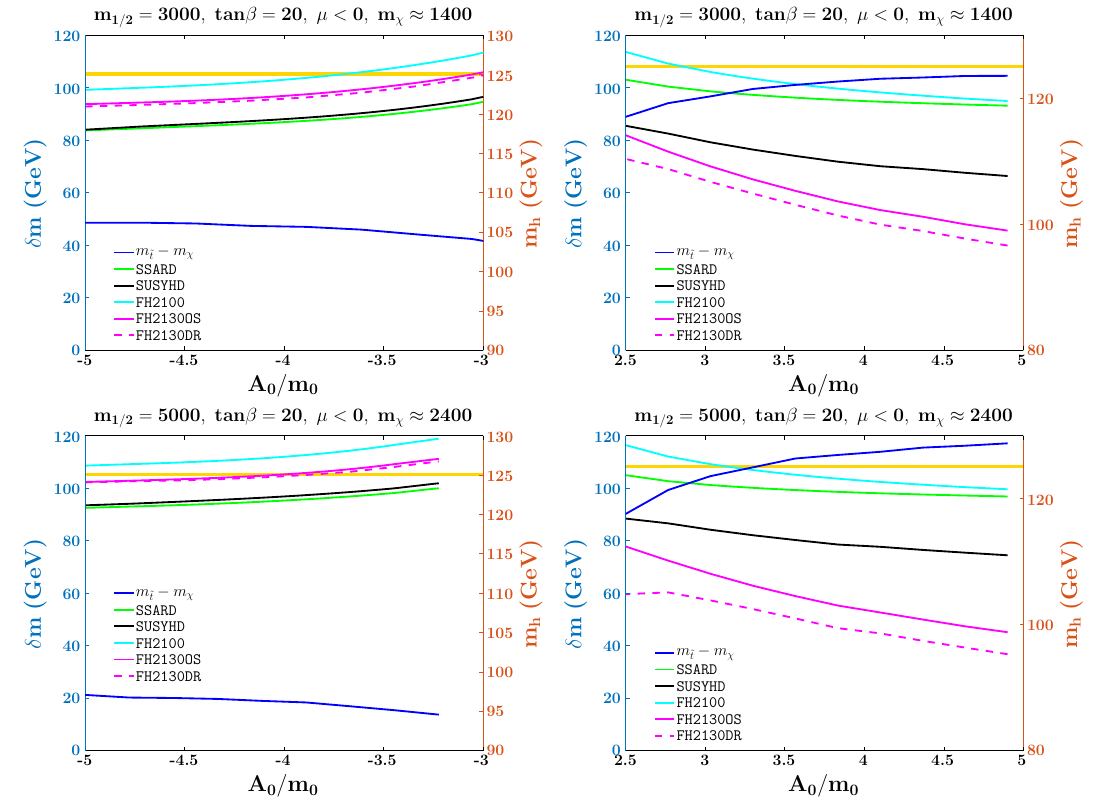
Fig. 4 Examination of Higgs mass for large A -terms along the stop coannihilation strip. The horizontal yellow strip corresponds to the 1 σ band for the Higgs boson mass, M h = 125 . 09 ± 0 . 24 GeV [155]